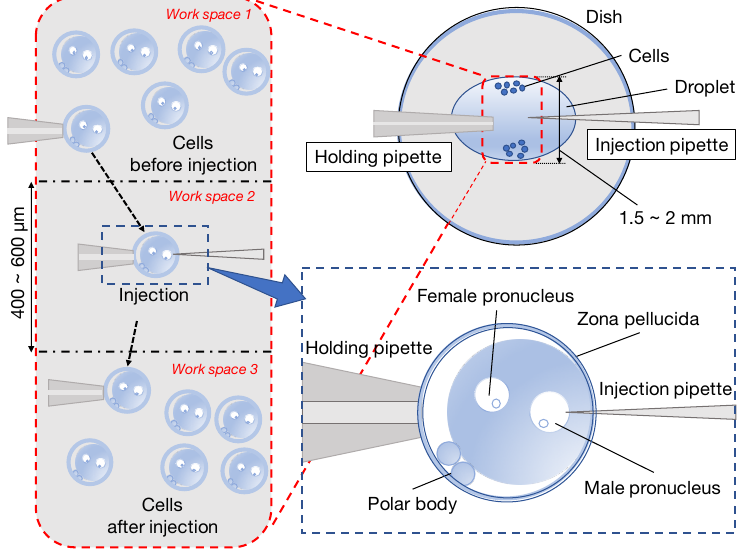
Figure 1. Workspaces for microinjection